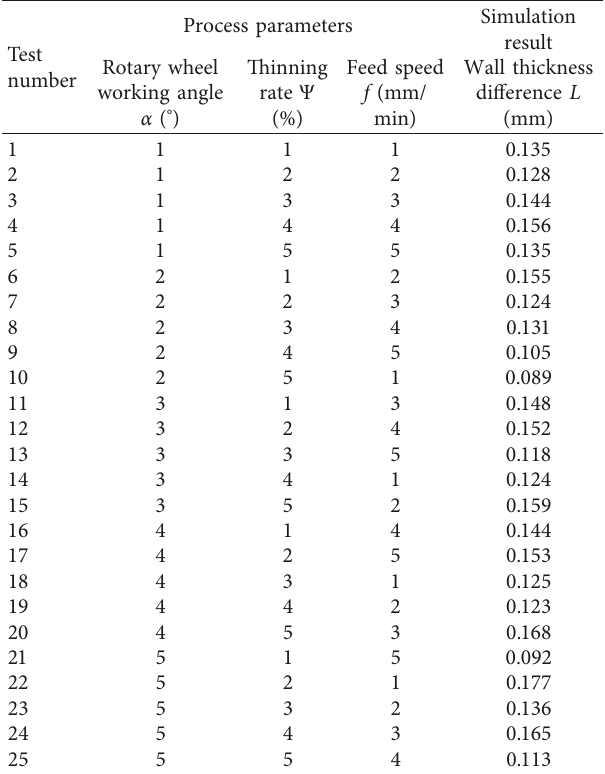
Table 4: Orthogonal test